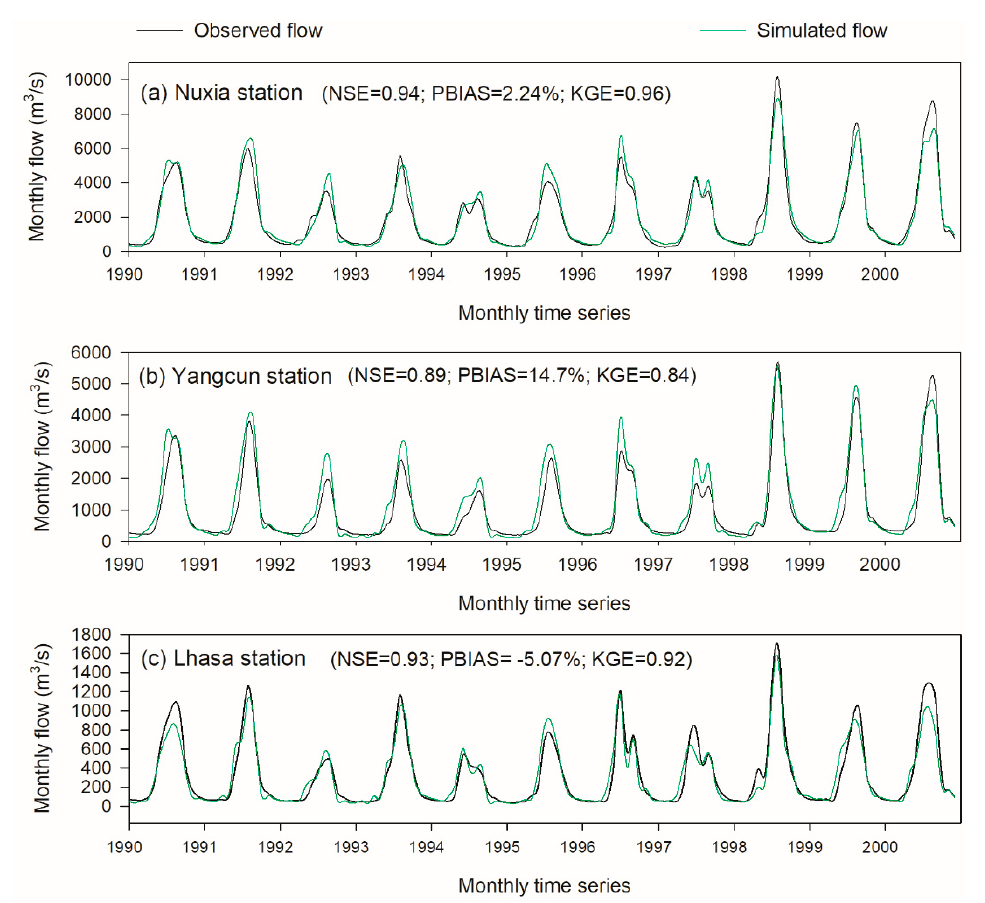
Figure 9. Monthly flow simulation at ( a ) Nuxia, ( b ) Yangcun, and ( c ) Lhasa hydrological stations during calibration period (1990–2000).